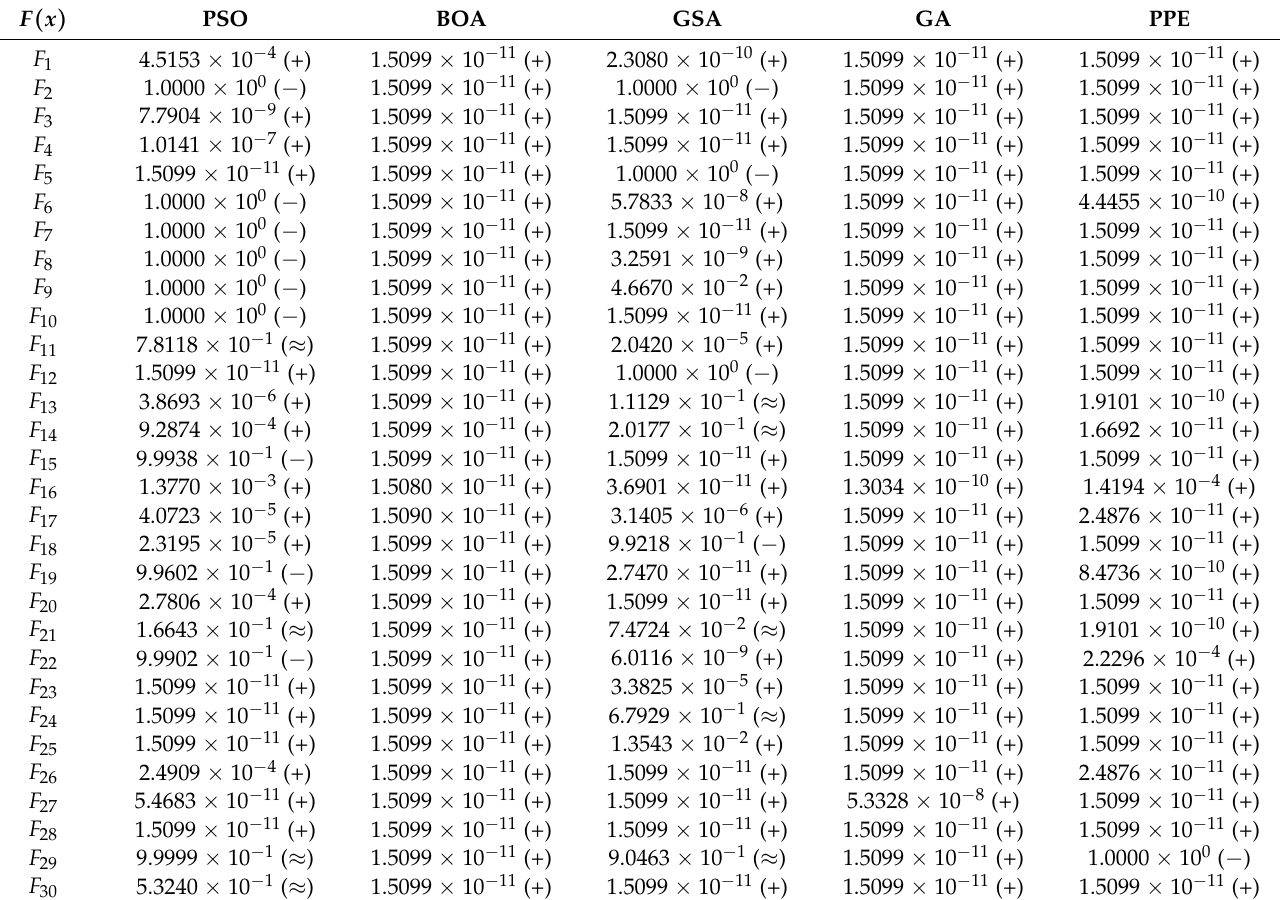
Table 2. Comparison with the results of PSO, BOA, GA, GSA and PPE at a significant level α = 0.05 under the Wilcoxon’s signed rank test.